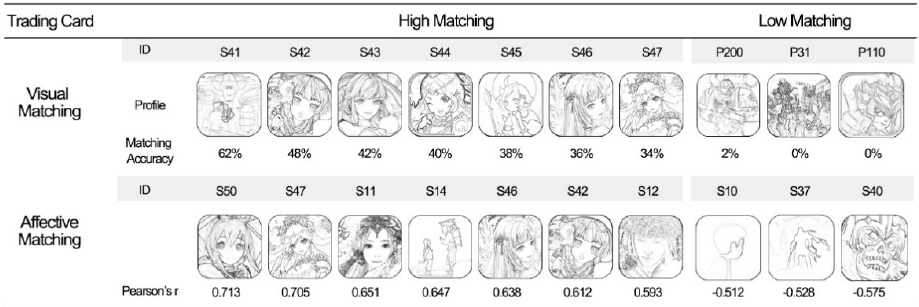
Figure 10. Trading card game icons with high perceptual matching.